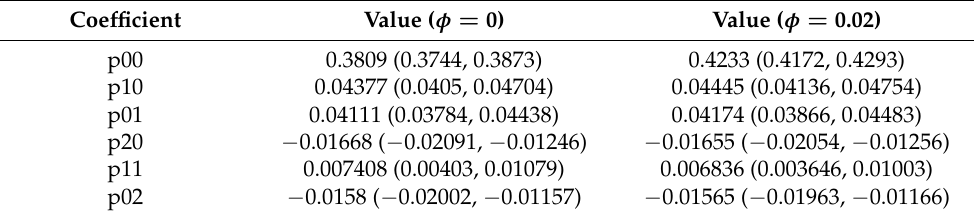
Table 3. Coefficients (with 95% confidence bounds).